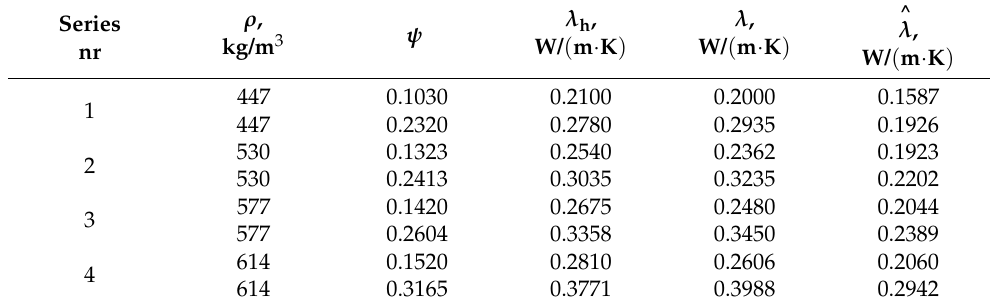
Table 2. Thermal conductivity values of moist cellular concrete samples determined experimentally λ h and computationally according to the two-step method λ and one-step method ˆ λ , apparent density ρ and moisture content ψ of the samples in four